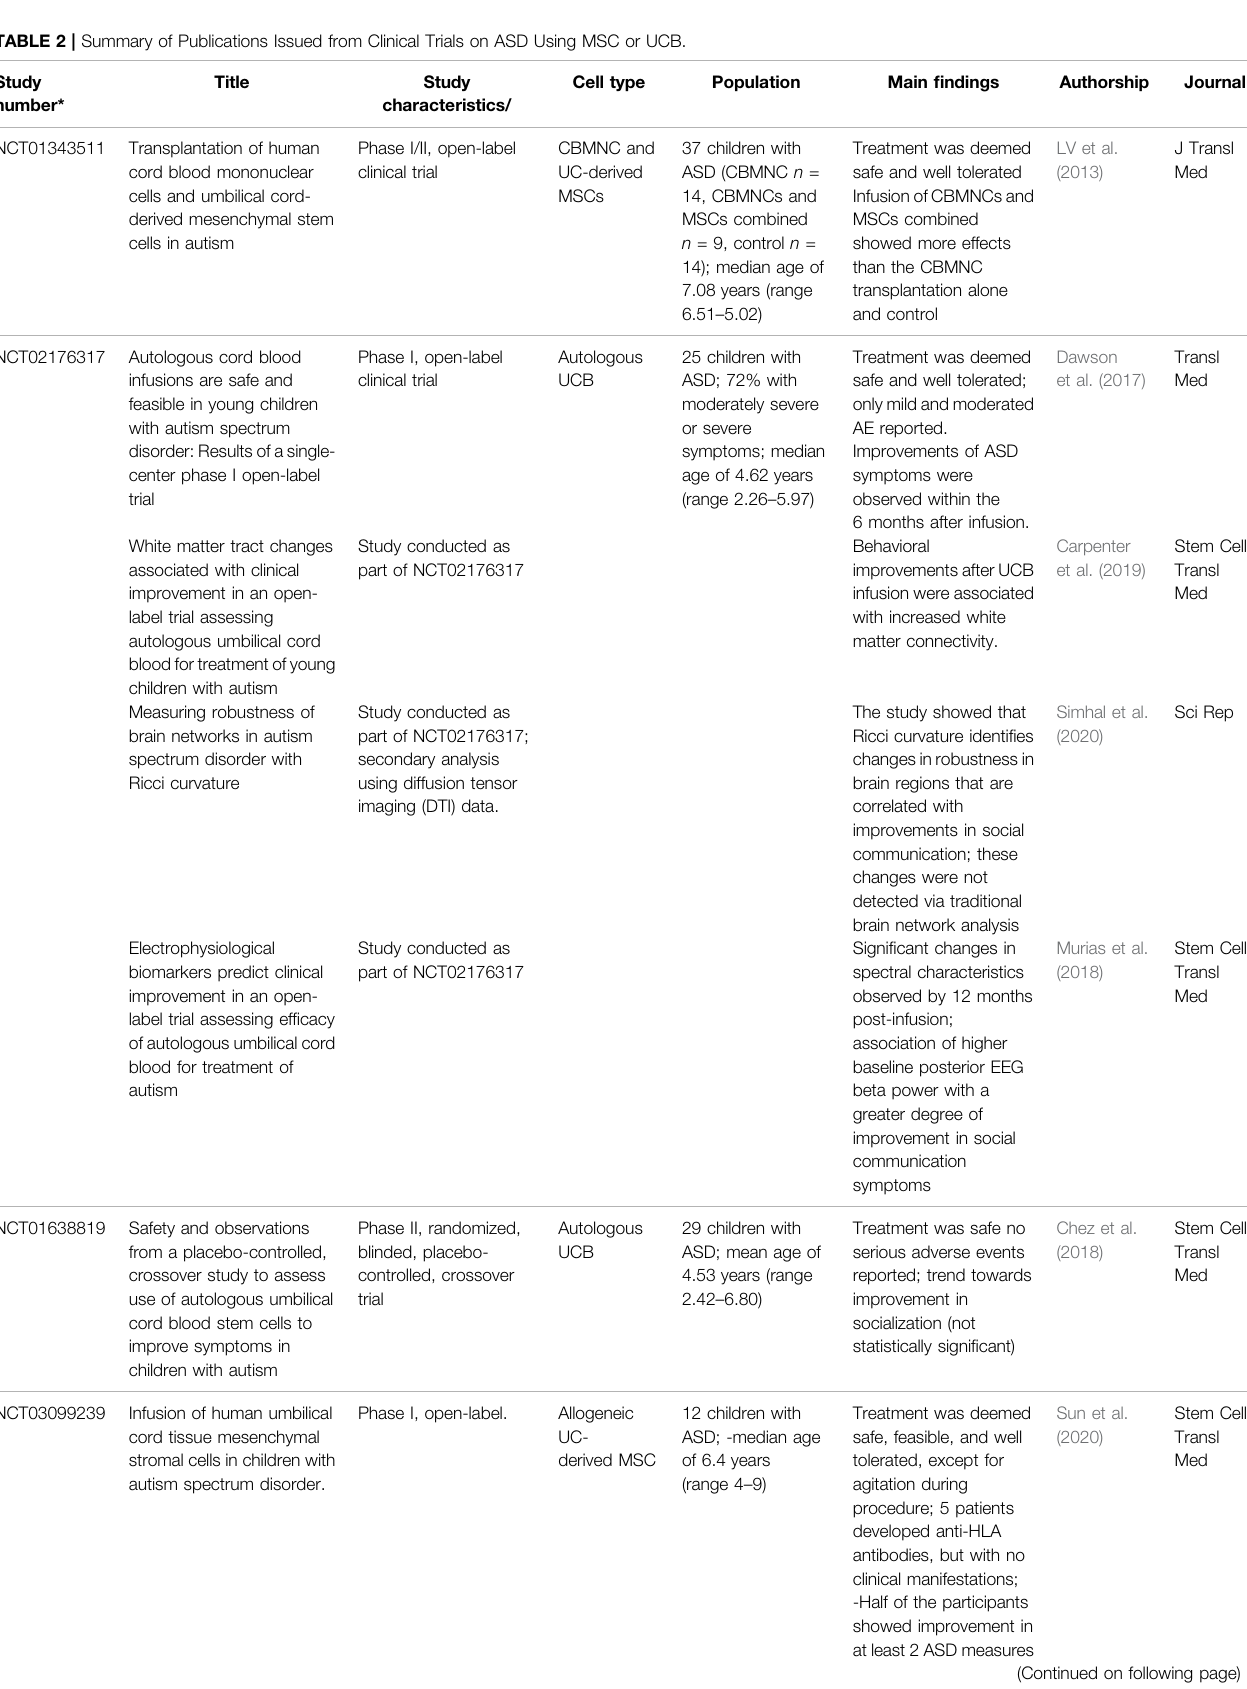
TABLE 2 | Summary of Publications Issued from Clinical Trials on ASD Using MSC or